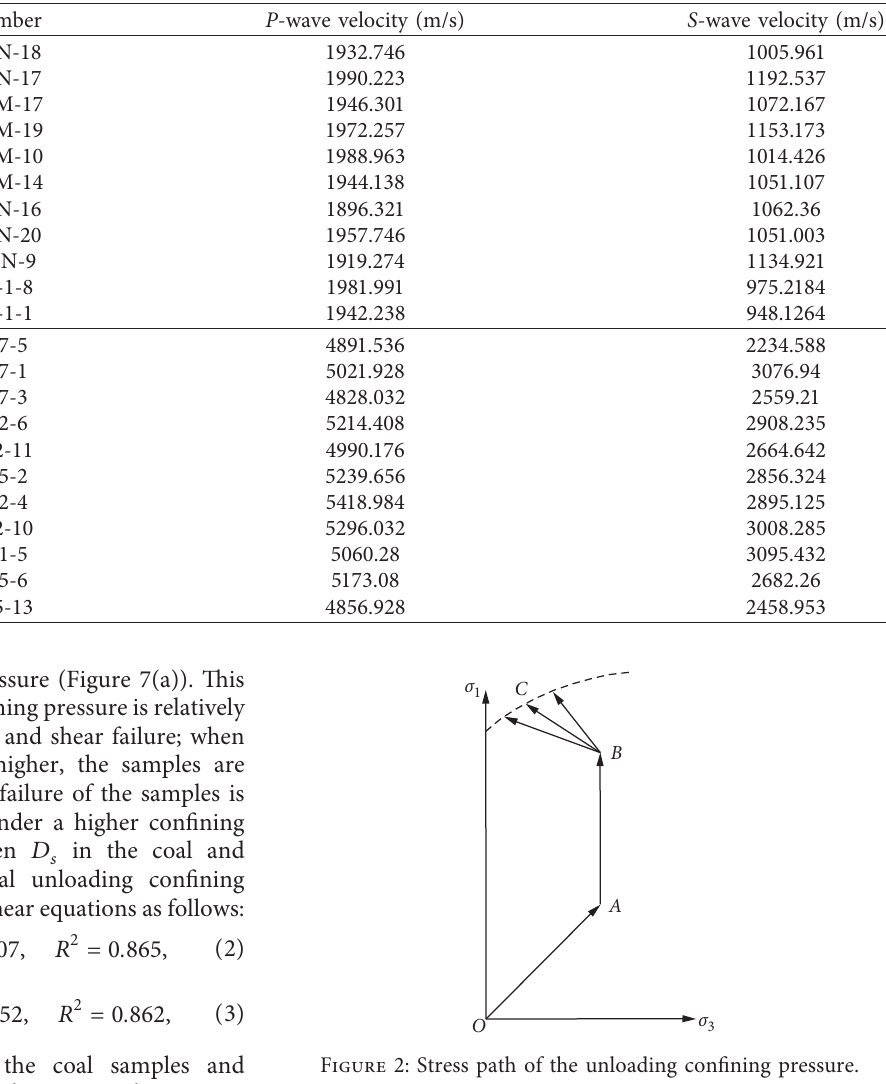
Table 1: Acoustic wave test results of typical rock specimens.